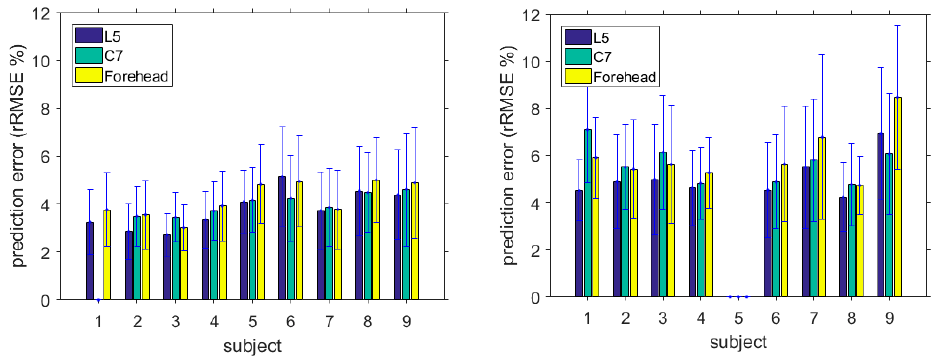
Figure 4. Effects of sensor location on prediction errors; left figure: OCW, right figure: OFW. Table 4. Mean and SD of prediction errors for OCW (rRMSE %) based on seventh cervical vertebra (C7) acceleration.